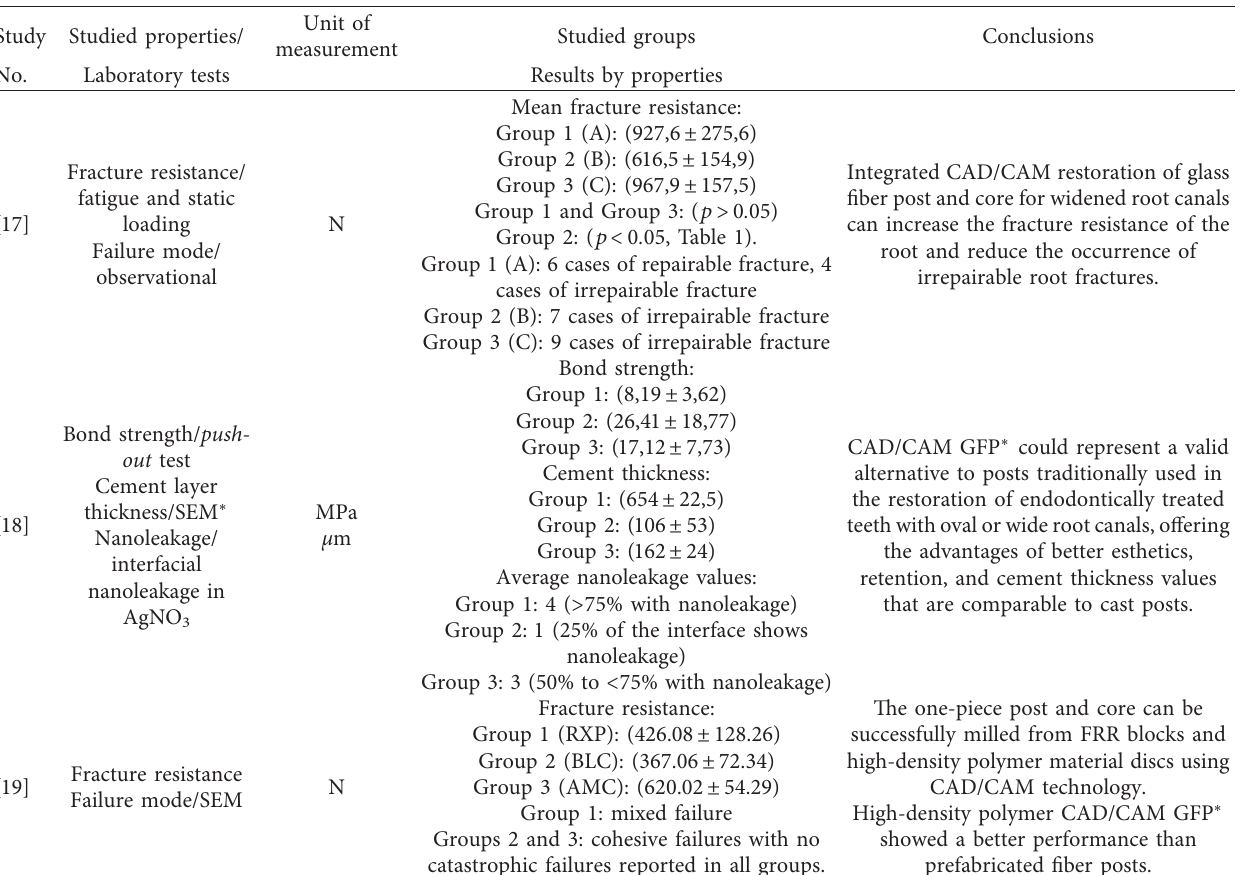
Table 4: Summary of the results of the 7 included